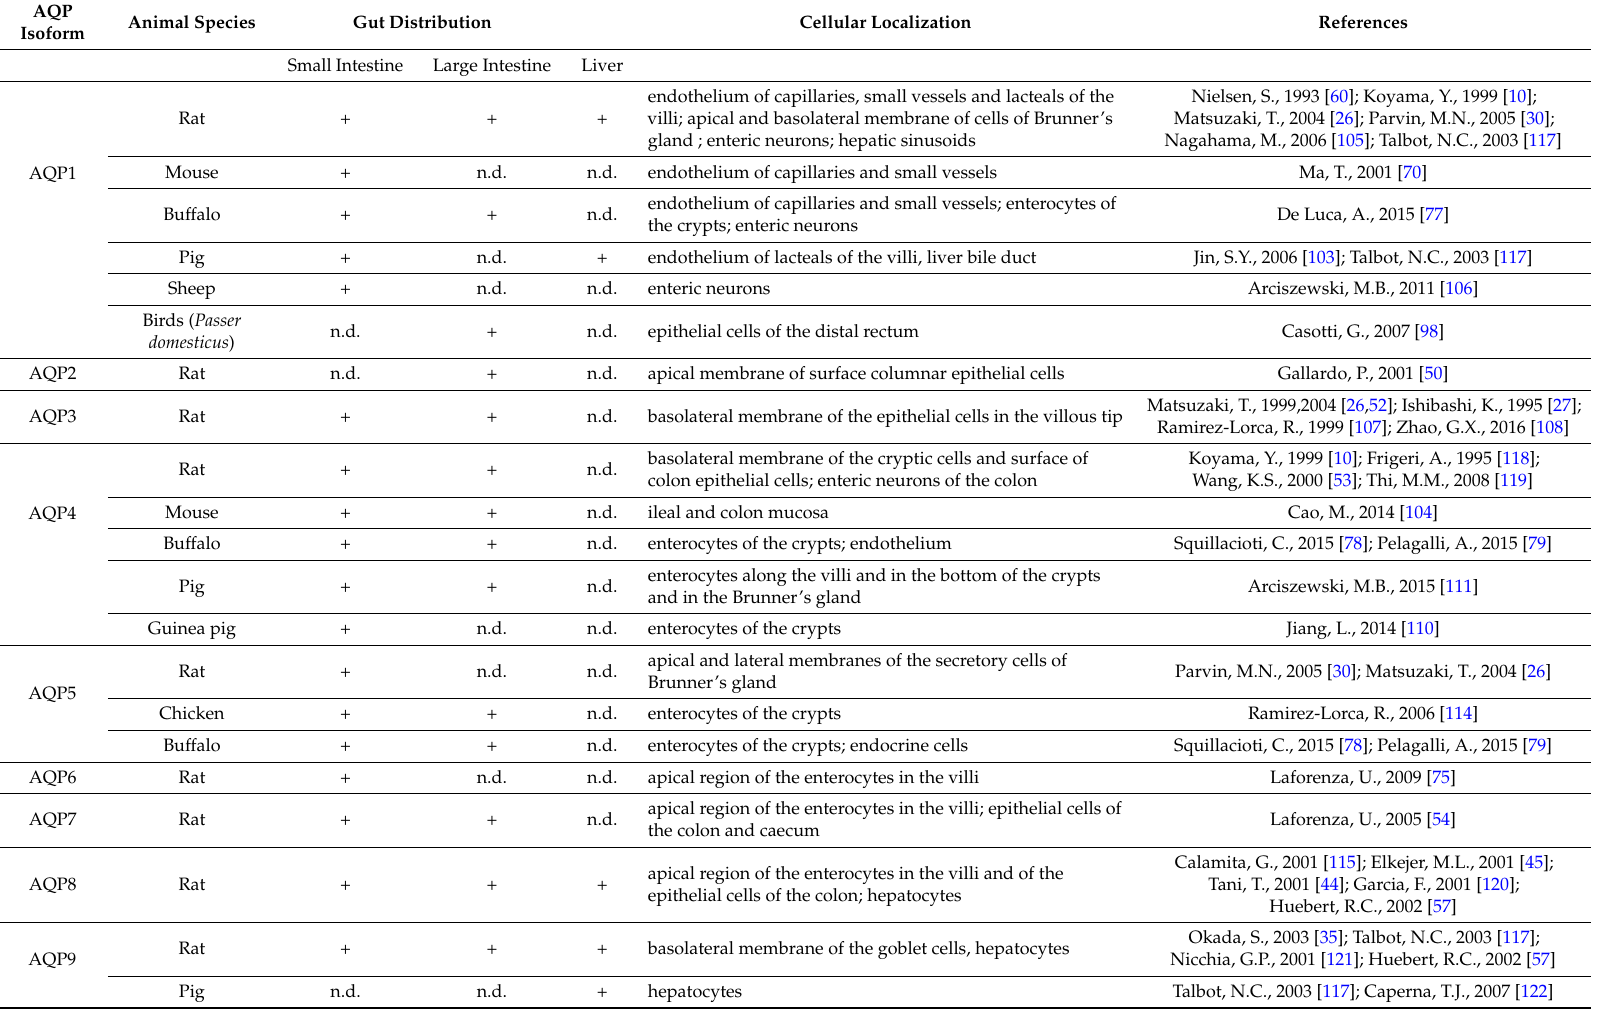
Table 2. Gut distribution of AQPs in different animal species (n.d. = not determined; +